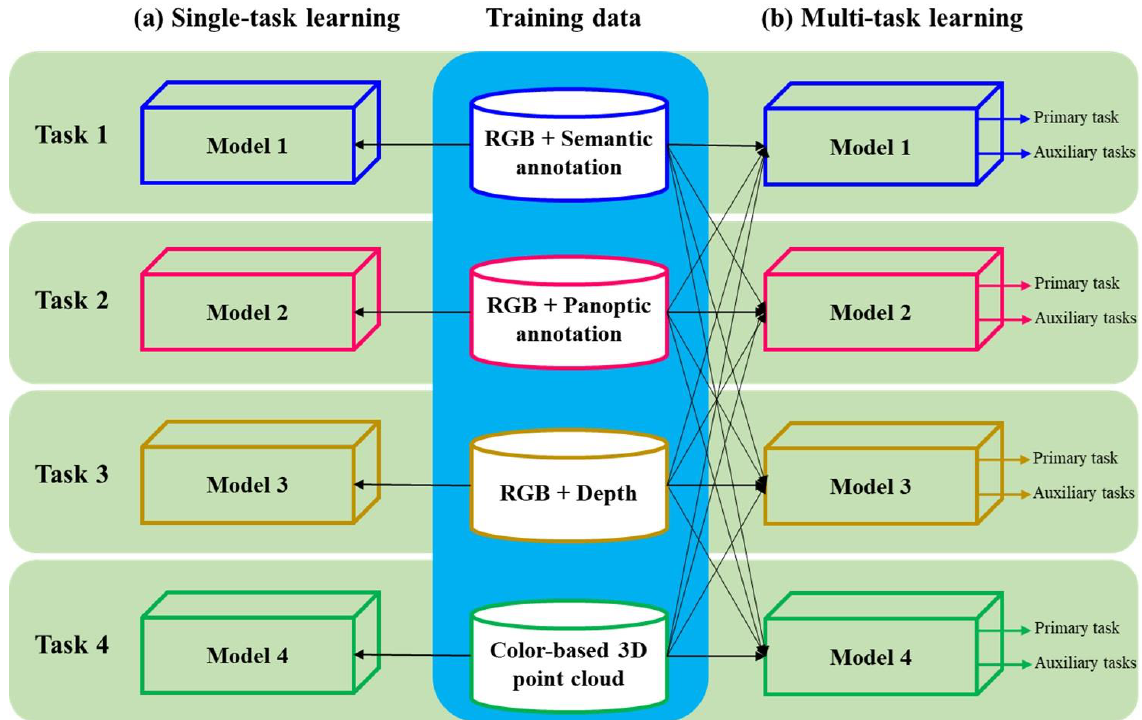
Figure 1. Difference between (a) single-task learning, and (b) multi-task learning